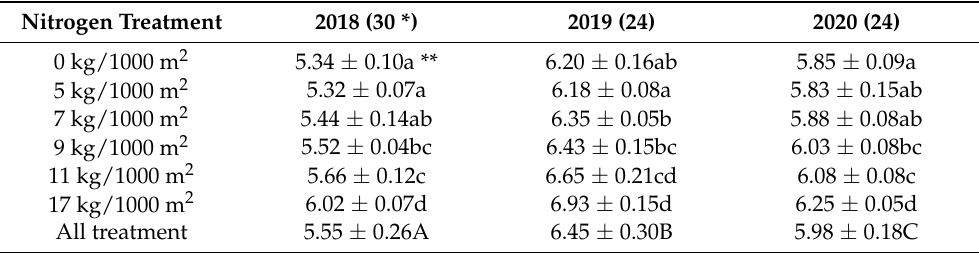
Table 5. Two-sample t-test among protein contents depending on the nitrogen fertilization treatment for each